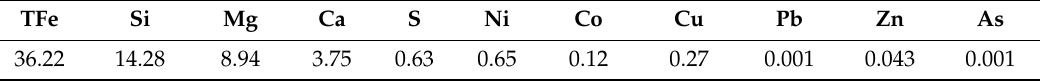
Table 1. Chemical composition of water-quenched nickel slag